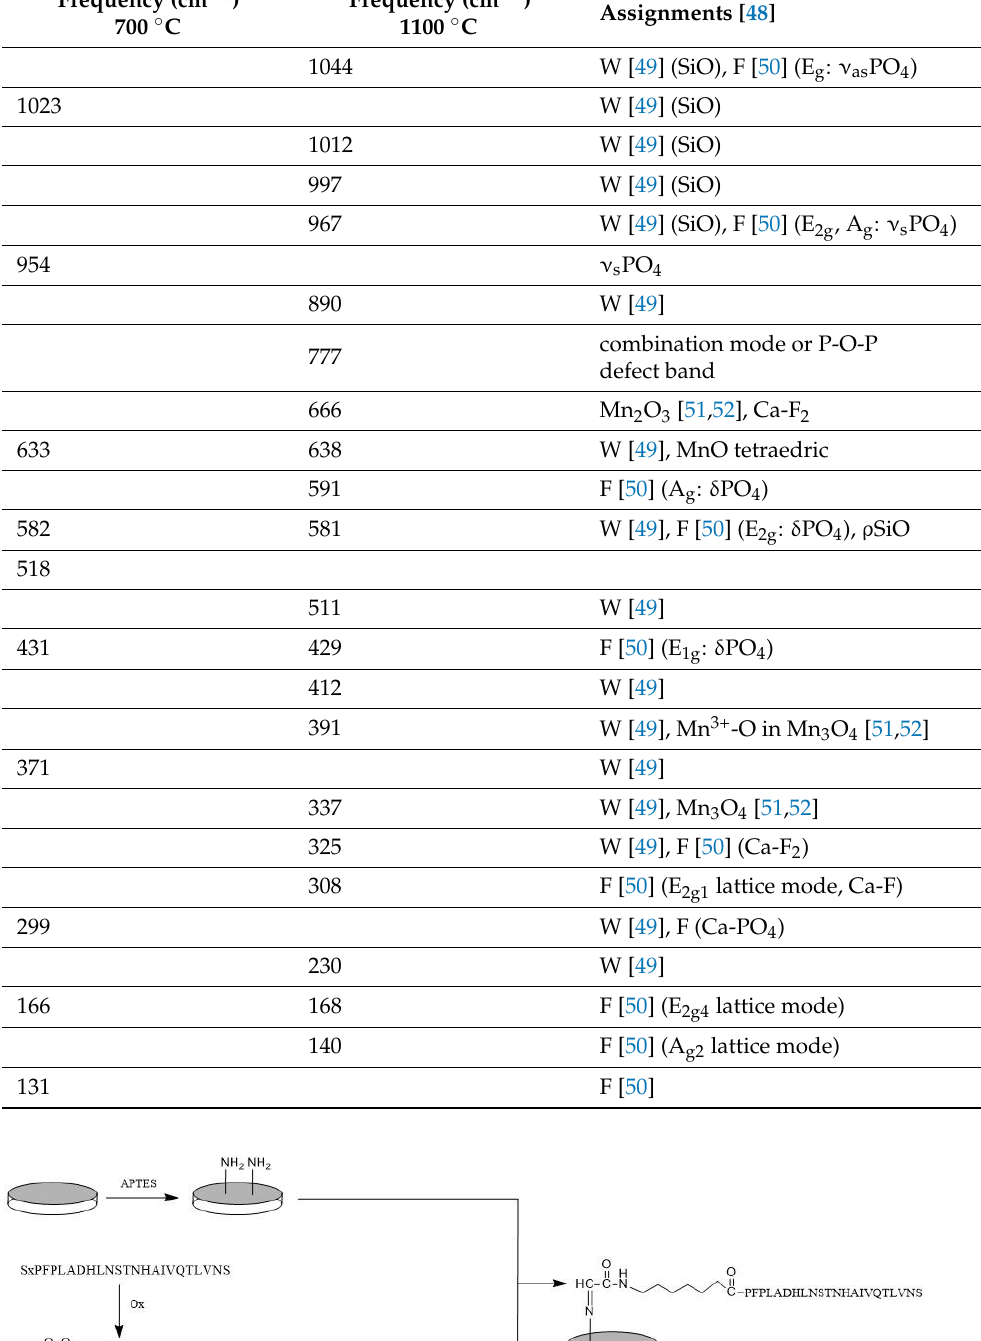
Table 3. Raman bands of the Mn-doped bioactive glass-ceramic after treatment at 700 and 1100 ◦ C.